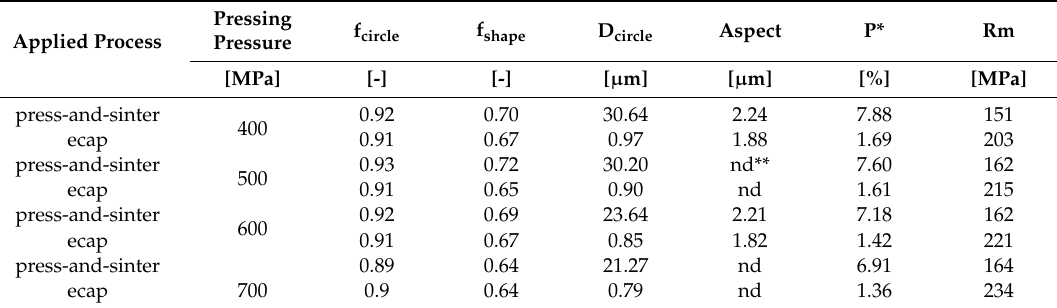
Table 1. The dimensional and morphological characteristics of porosity, as well as porosity value and tensile strength for investigated aluminum alloy.